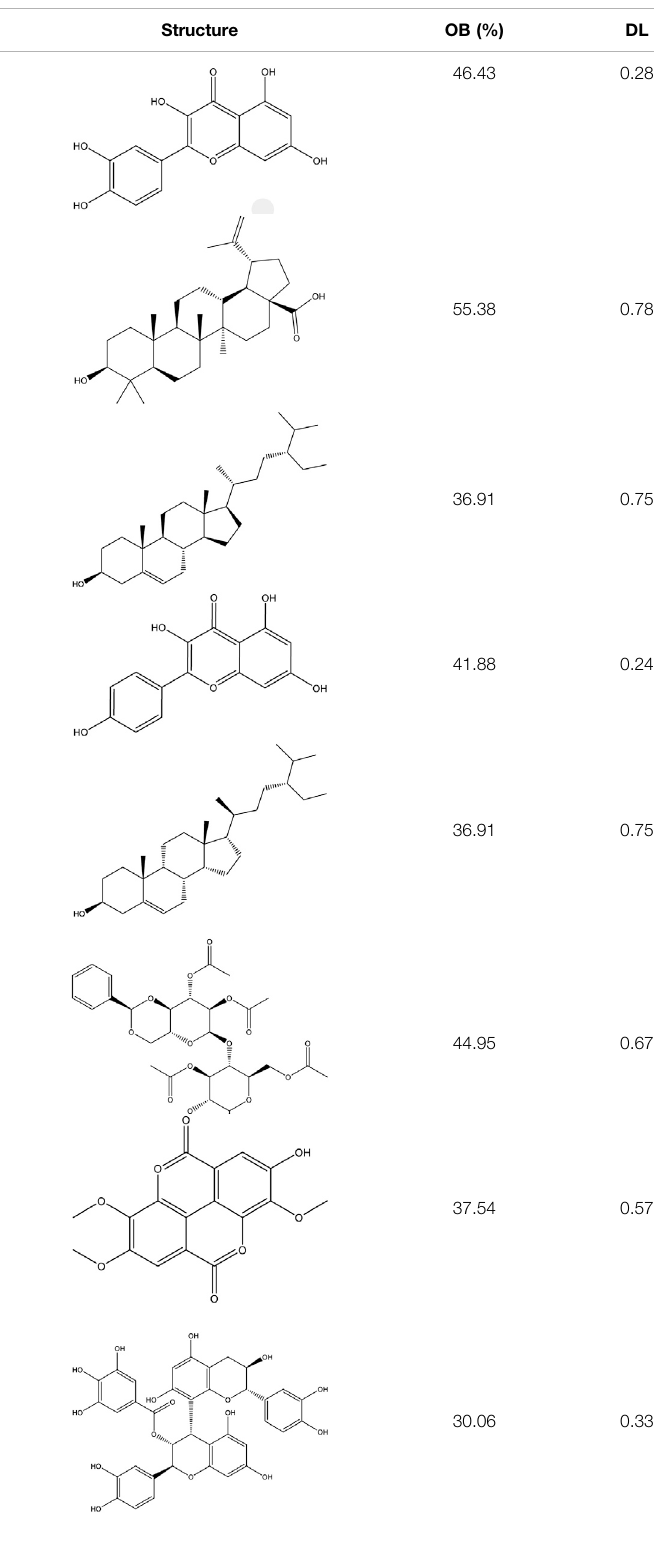
TABLE 1 | Active ingredients and ADME parameters of